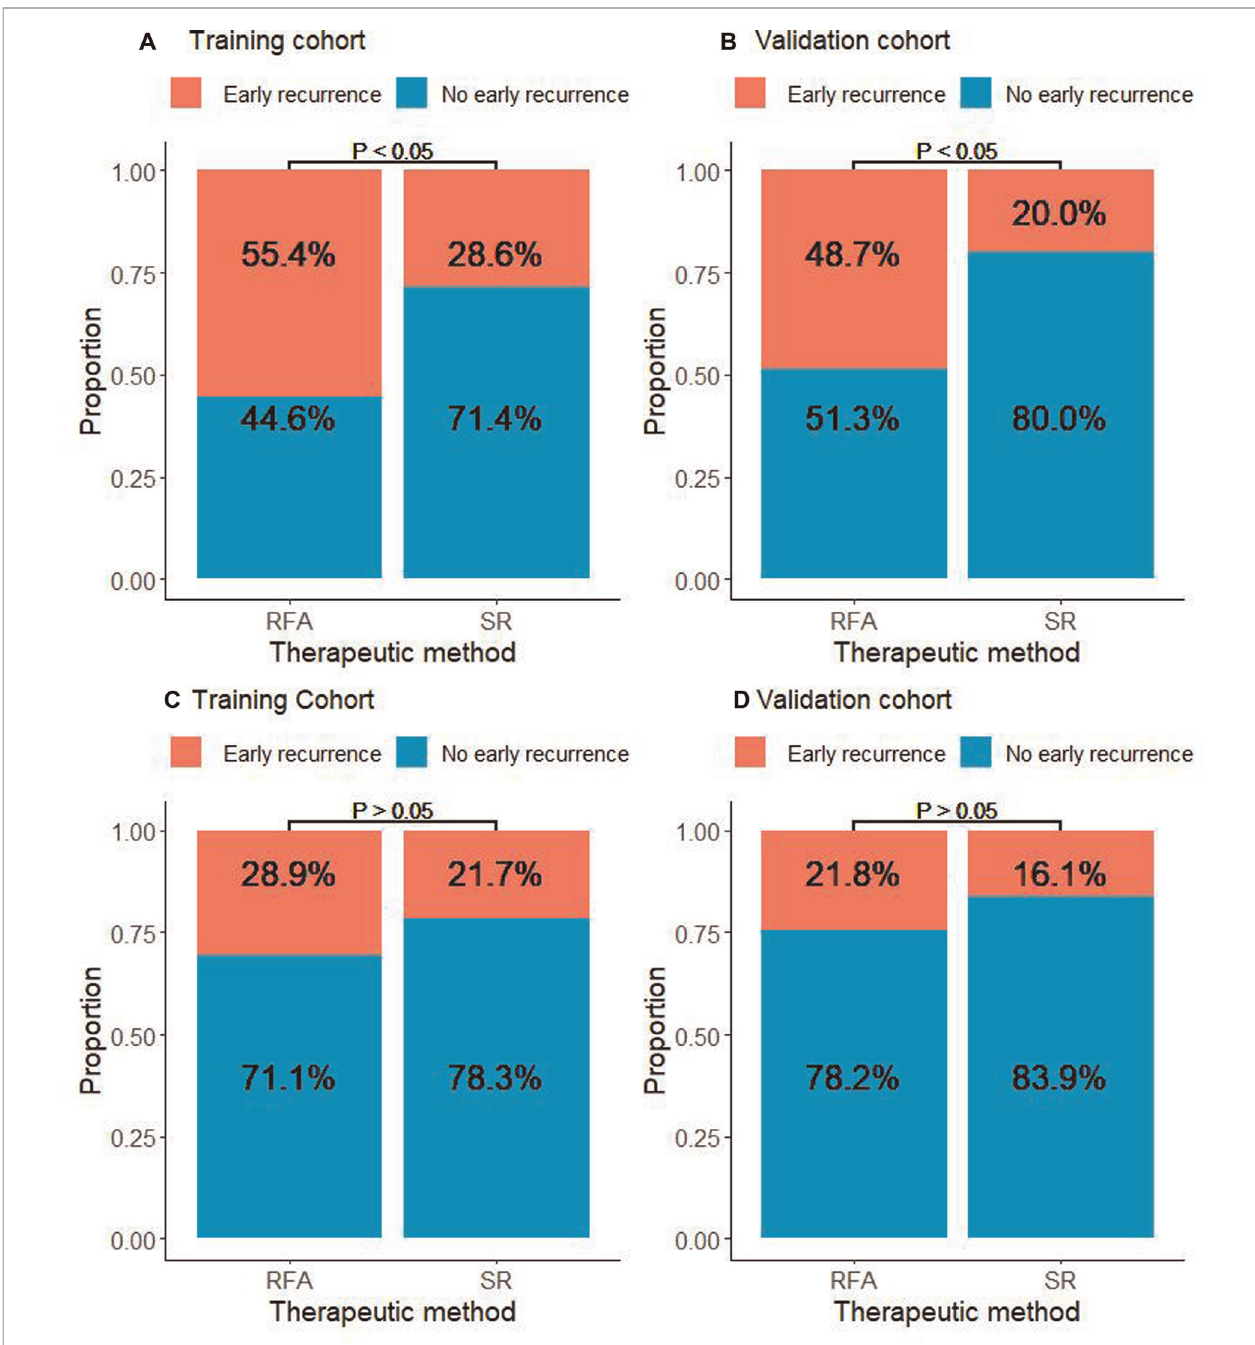
FIGURE 3 | Association between RFA and early recurrence in HCC patients strati fi ed by CTC. ( A ) Proportion of CTC-positive patients who experienced early or non- early recurrence in the RFA and SR groups in the training cohort. ( B ) Proportion of CTC-positive patients who experienced early or non-early recurrence in the RFA and SR groups in the validation cohort. ( C ) Proportion of CTC-negative patients who experienced early or non-early recurrence in the RFA and SR groups in the training cohort. ( D ) Proportion of CTC-negative patients who experienced early or non-early recurrence in the RFA and SR groups in the validation